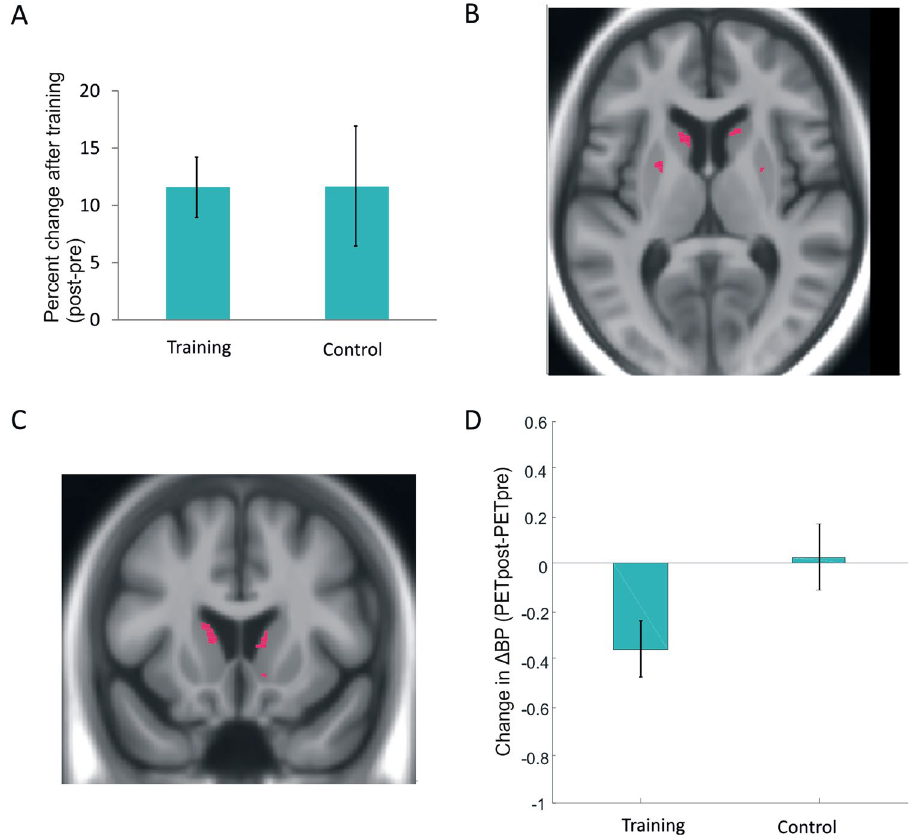
Figure 2. Behavioral and dopamine effects for the n-back transfer task. ( A ) Percent pre-post changes in 3-back. ( B ) Lower raclopride binding to striatal D2 receptors during 3-back compared to 1-back before training in bilateral striatum, reflecting greater DA release in response to the cognitive challenge (x,y,z = 27,0,0; 11,18,6; − 23,0,8; − 12,15,11). ( C ) Effects in bilateral striatum (x,y,z = 11,14, − 9; − 17,15,14) showing a training-induced decrease of raclopride binding to D2 receptors during 3-back. ( D ) Bar graph showing a selective training- related reduction in right striatum for trained subjects. Error bars are standard